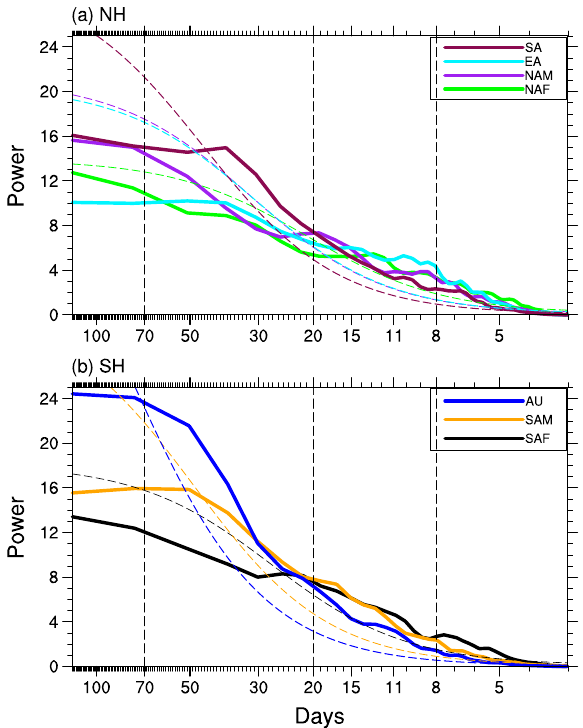
Fig. 2 Power spectra of ISVs of individual summer monsoons. Power spectra of the 3-day running mean precipitation anomalies (mm day − 1 ) averaged over each monsoon region for a NH and b SH during the summers of 1979 – 2018. Daily climatology is removed to obtain the anomalies. Each monsoon precipitation series is normal- ized before the spectrum analysis. Dashed lines denote the corresponding 90% con fi dence level.